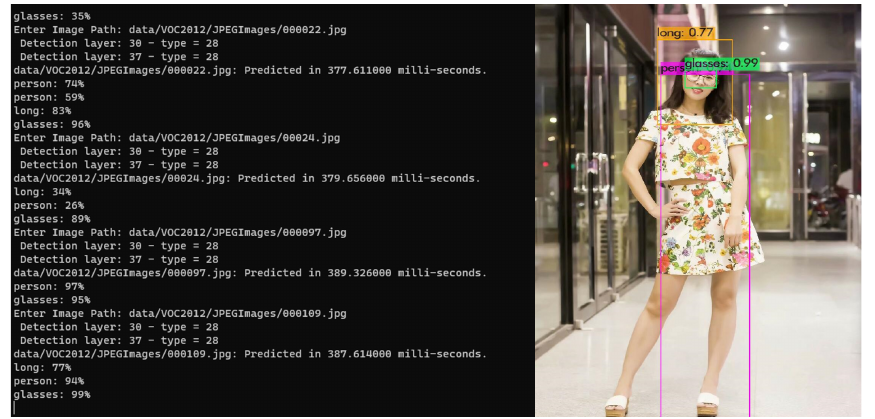
Figure 8. Recognition result.